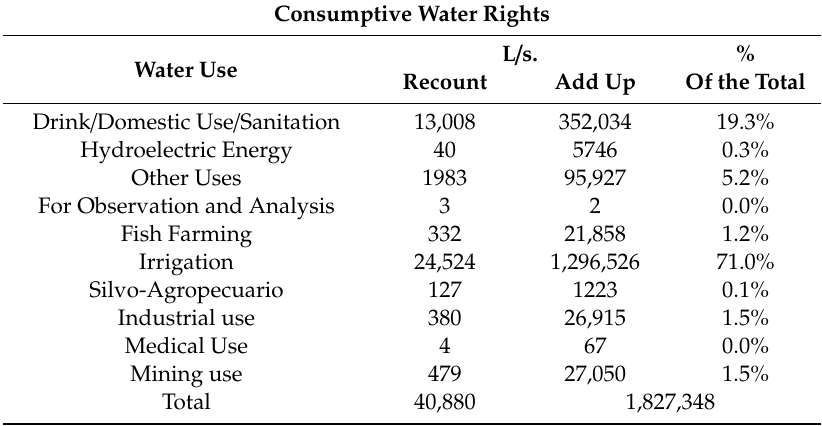
Table 2. Consumptive water rights by use, excluding “No data” cases. Source: Author’s elaboration based on DGA